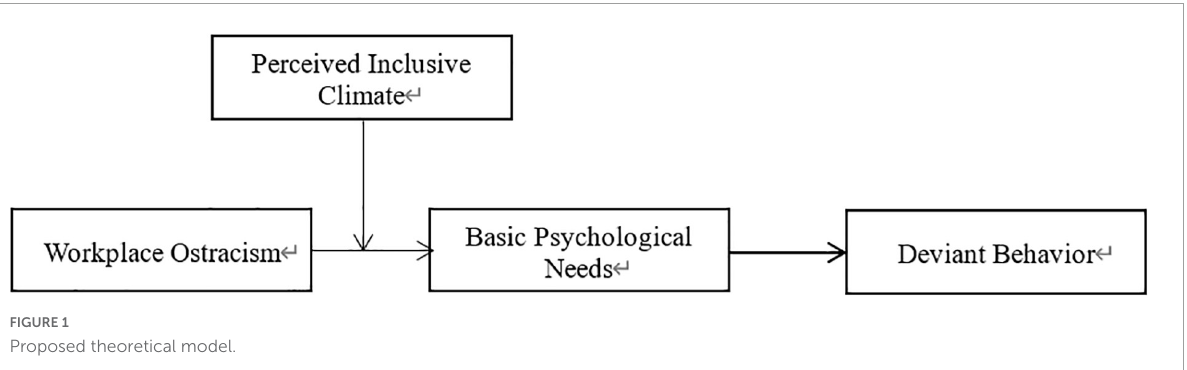
FIGURE1 Proposed theoretical